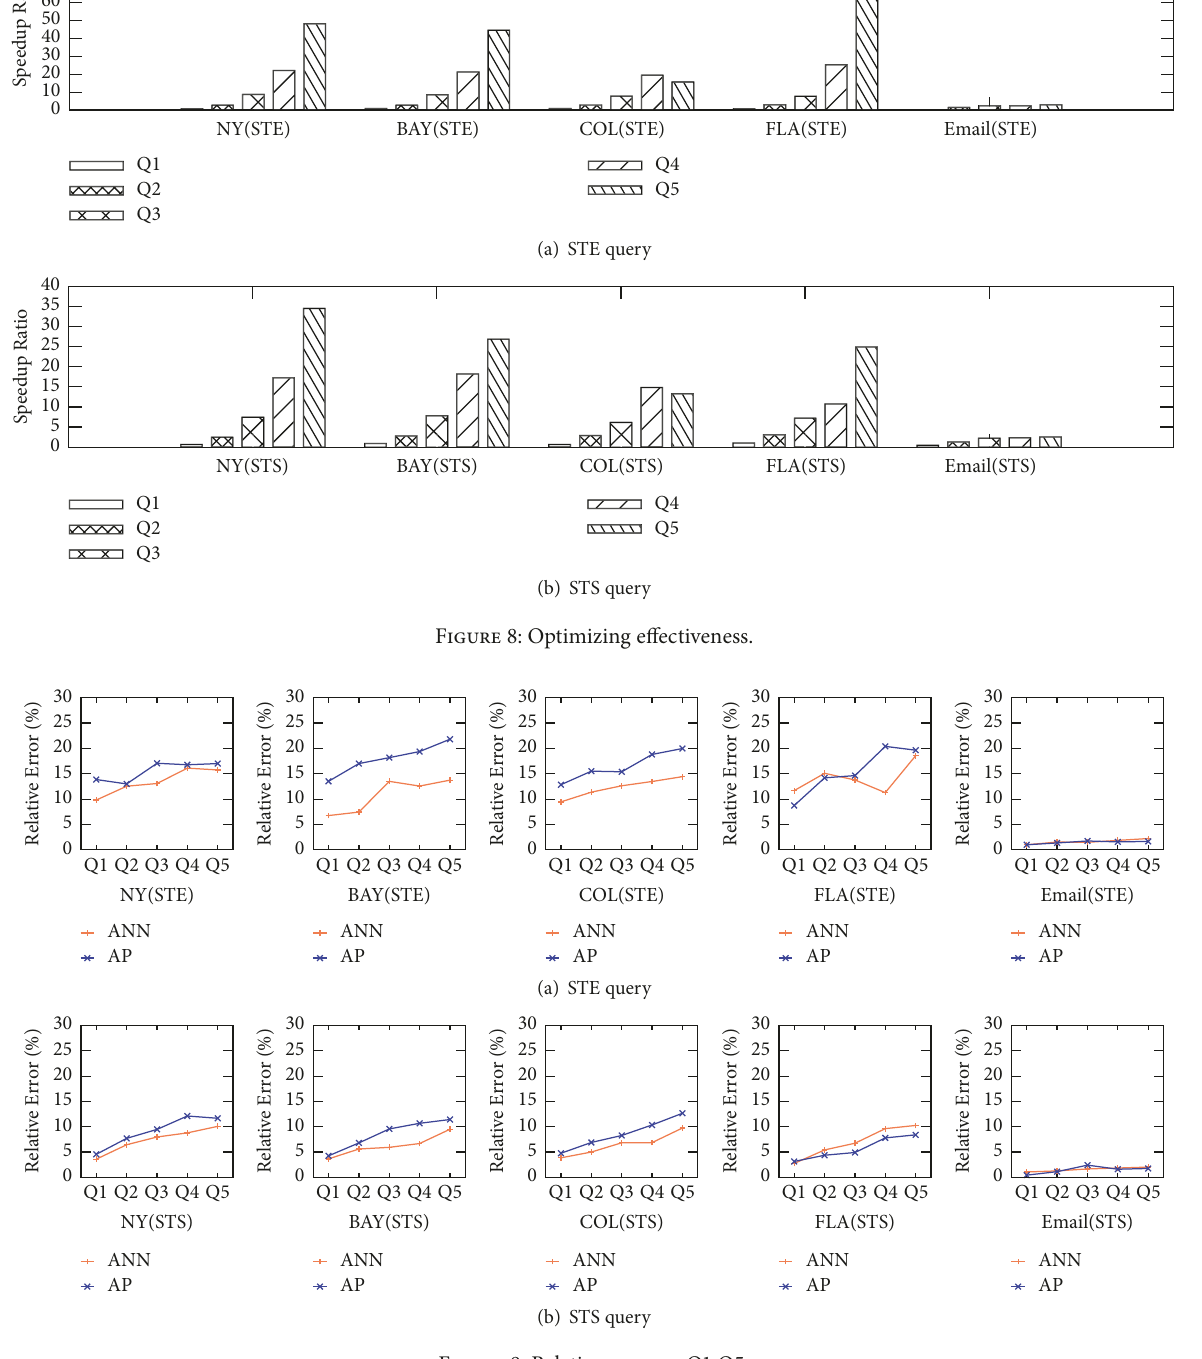
Figure 9: Relative error on